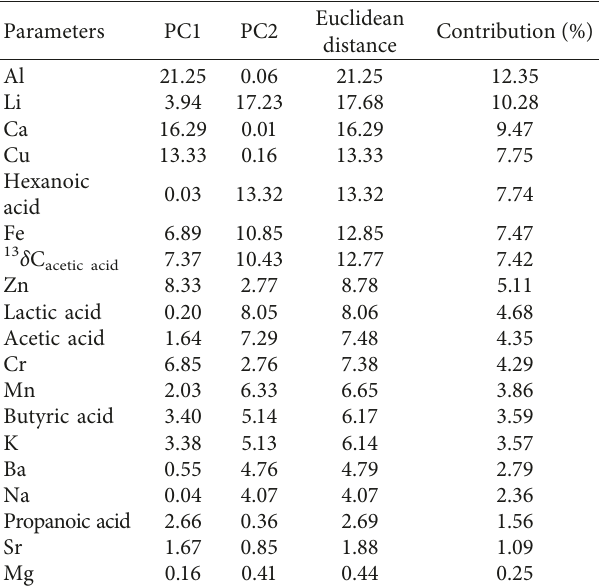
Table 6: Nineteen parameters of variables on two principle components of principal component analysis from seven different origins.